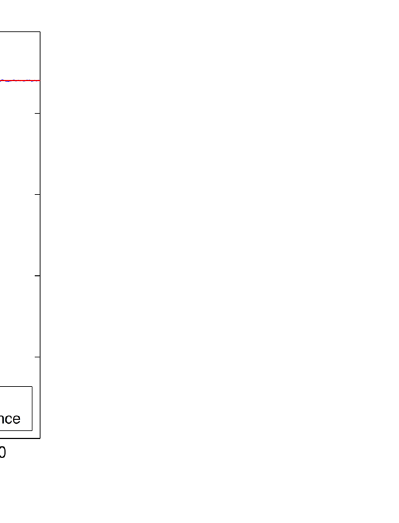
Figure 23. Flow rate control experiment Scenario